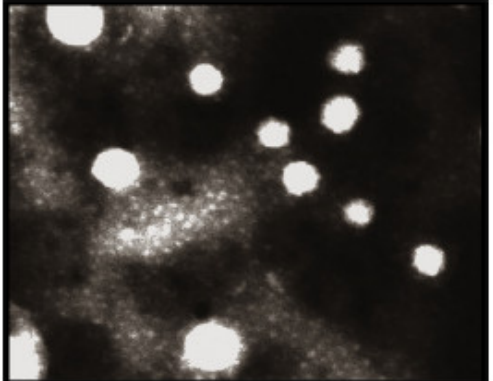
Figure 6. Quercetin-loaded nanoemulsion globules’ morphology was observed using TEM at a voltage of 60–80 kV (magnification 10,000, scale 200 nm) [43]. “Reproduced with permission from reference”.